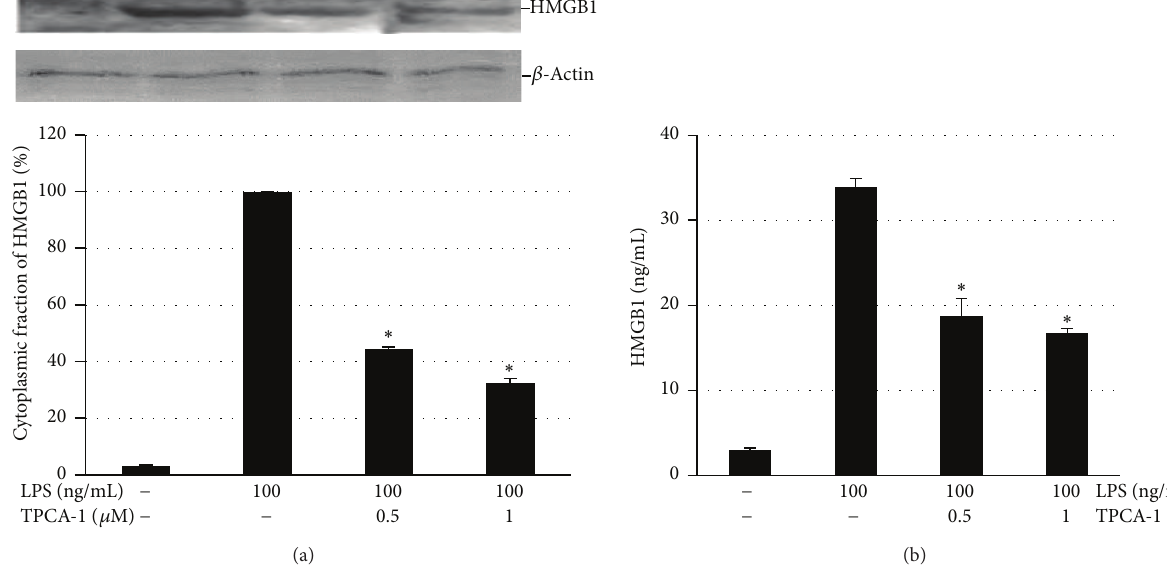
Figure 5: Inhibition of NF- 𝜅 B activation attenuated LPS-induced HMGB1 translocation from the nucleus to the cytoplasm and release in OLC-1. Cells were pretreated with the selective inhibitor of human IKK-2 (TPCA-1), 2 h before the cells were stimulated with LPS for 24 h. (a) The cells were harvested, and the cytoplasmic proteins were isolated for analysis of HMGB1 by western blotting. A representative blot using antibodies against HMGB1 and 𝛽 -actin is shown. HMGB1 expression was quantified by densitometry and normalized to 𝛽 -actin. (b) HMGB1 release into the supernatant was analyzed by ELISA. Results are expressed as the means ± SD from triplicate experiments. ∗ 𝑃 < 0.001